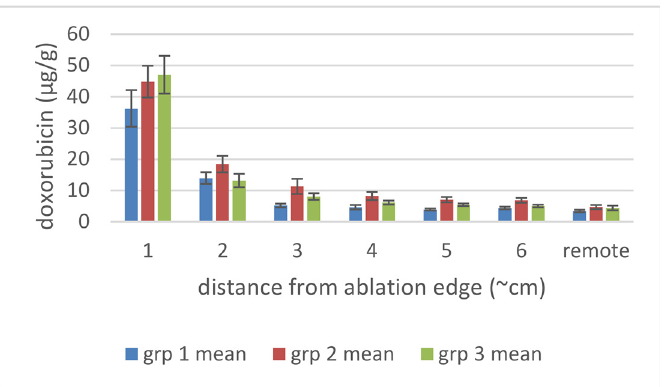
Fig 6. Mean ( ± SEM) doxorubicin tissue concentrations around the ablation zones of pigs in Study C. Punch biopsies were collected radiating out from the liver ablation zone after 1 (group 1, n = 3), 3 (group 2, n = 3) or 6 (group 3, n = 3) sequential, overlapping ablations using the Angiodynamics device. Distance 1 is just adjacent to the ablation margin and distance 6 is the furthest away from the ablation